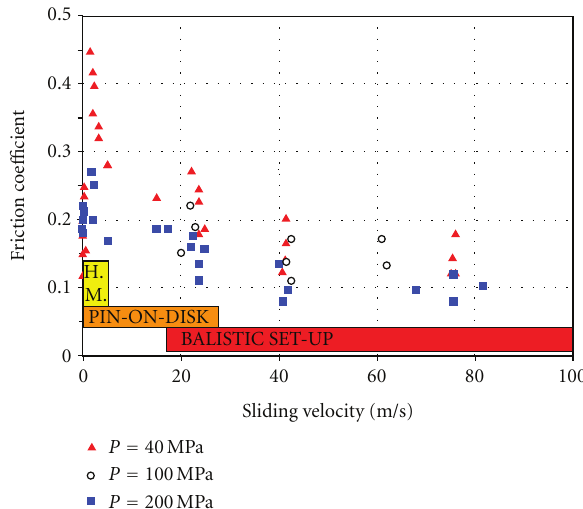
Figure 6: Evolution of the friction coe ffi cient for a steel on steel contact.